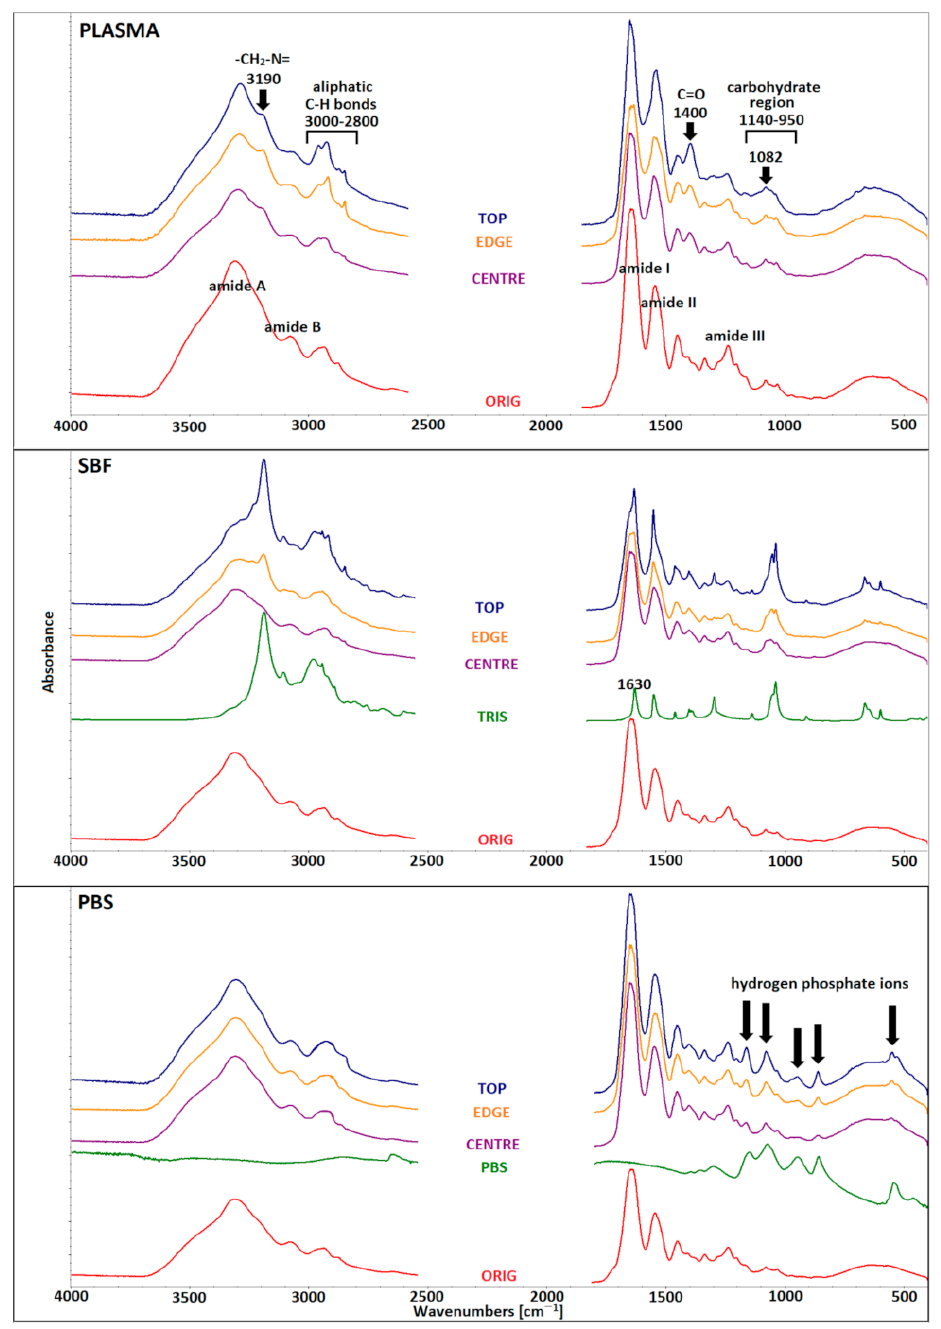
Figure 7. Comparison of the FTIR spectra of all the studied materials. The middle-infrared spectral region (4000–400 cm − 1 ) was employed for comparison